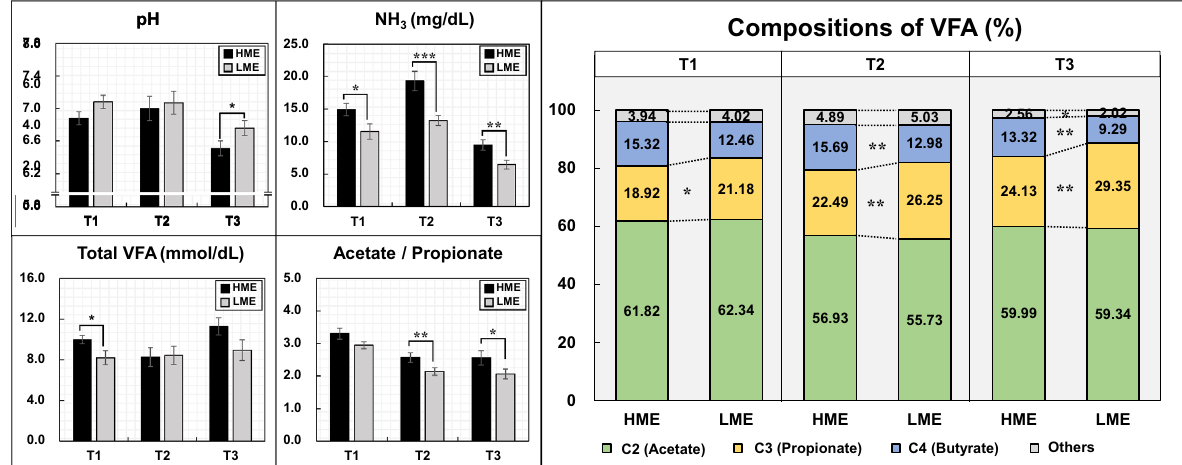
Figure 3. Compositions of rumen fermentations in HME vs LME cattle during the fattening period. T1: early fattening phases (13 months of age), T2: middle fattening phases (20 months of age), T3: late fattening phases (28 months of age). HME: group of high methane emission cattle (n = 6), LME: group of low methane emission cattle (n = 6). VFA: volatile fatty acid. Data are presented as mean ± SEM. * p < 0.1, ** p < 0.05, and *** p < 0.01.